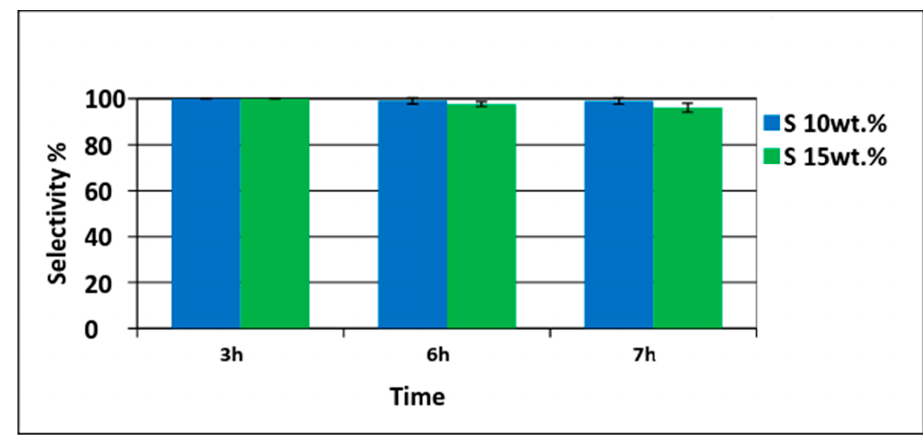
Figure 7. Conversion of phenol using 10 wt% (phenol 1.5g (0.0159 moles) with palladium 0.15 g (0.0014 moles)) and 15 wt% (phenol 1.5 g (0.0159 moles) with palladium 0.225g (0.0021 moles)) of electrospun catalysts.